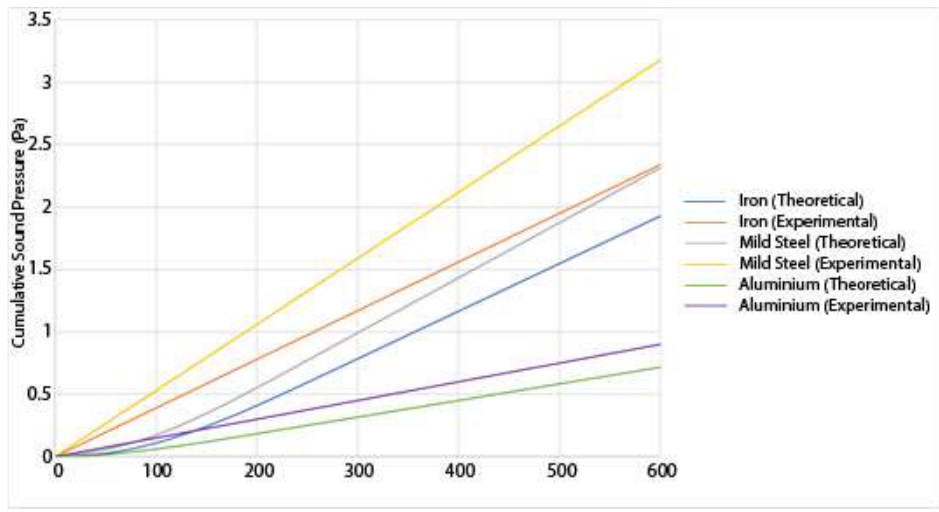
Figure 11. Experimental and theoretical results for the sound generation of various materials un- dergoing sliding friction under a 10 N load.